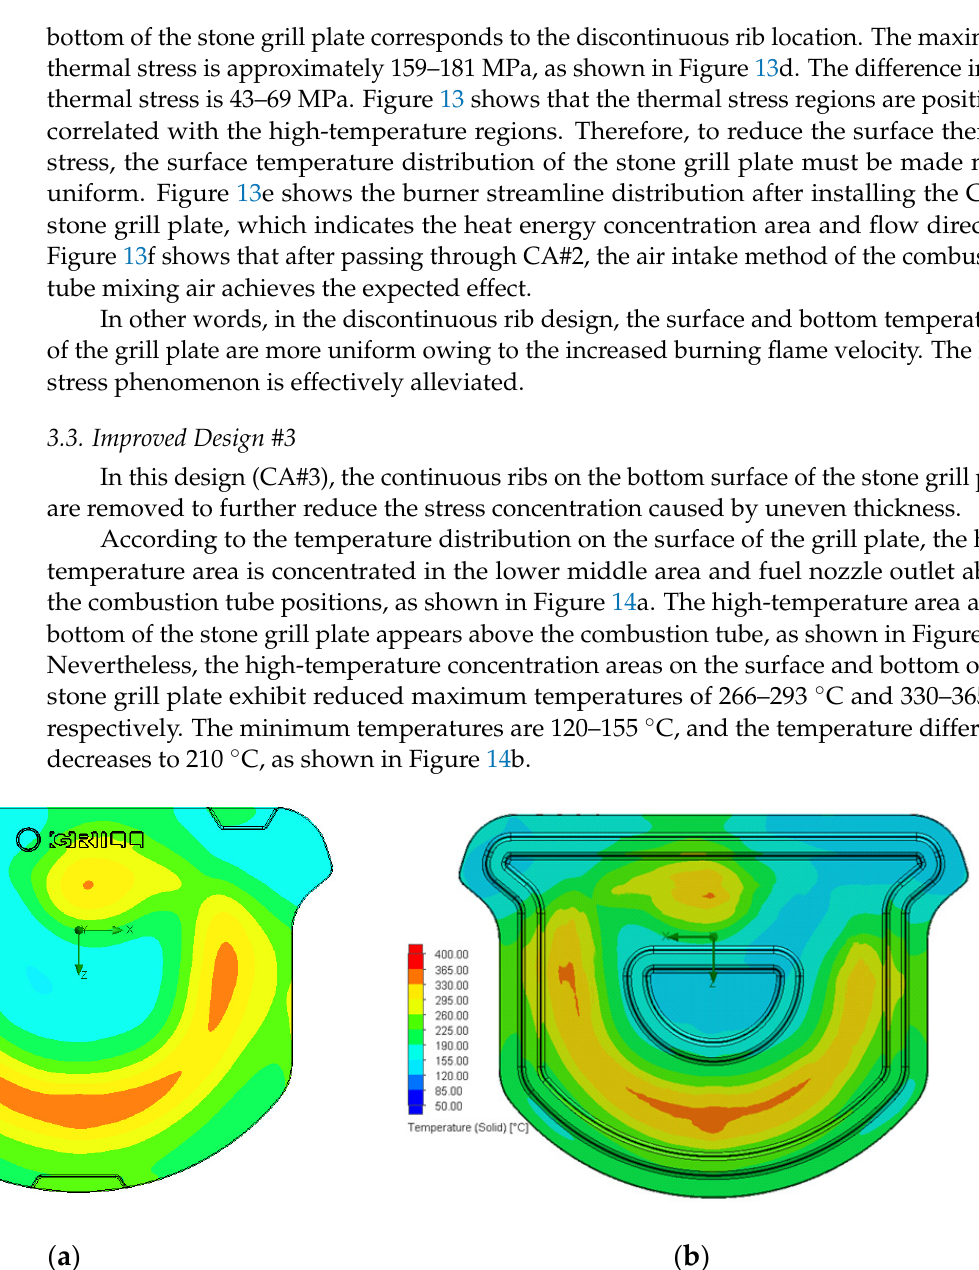
( b ) Figure 15. ( a ) Thermal stress distribution on the ( a ) surface and ( b ) bottom of the CA#3 stone grill plate.